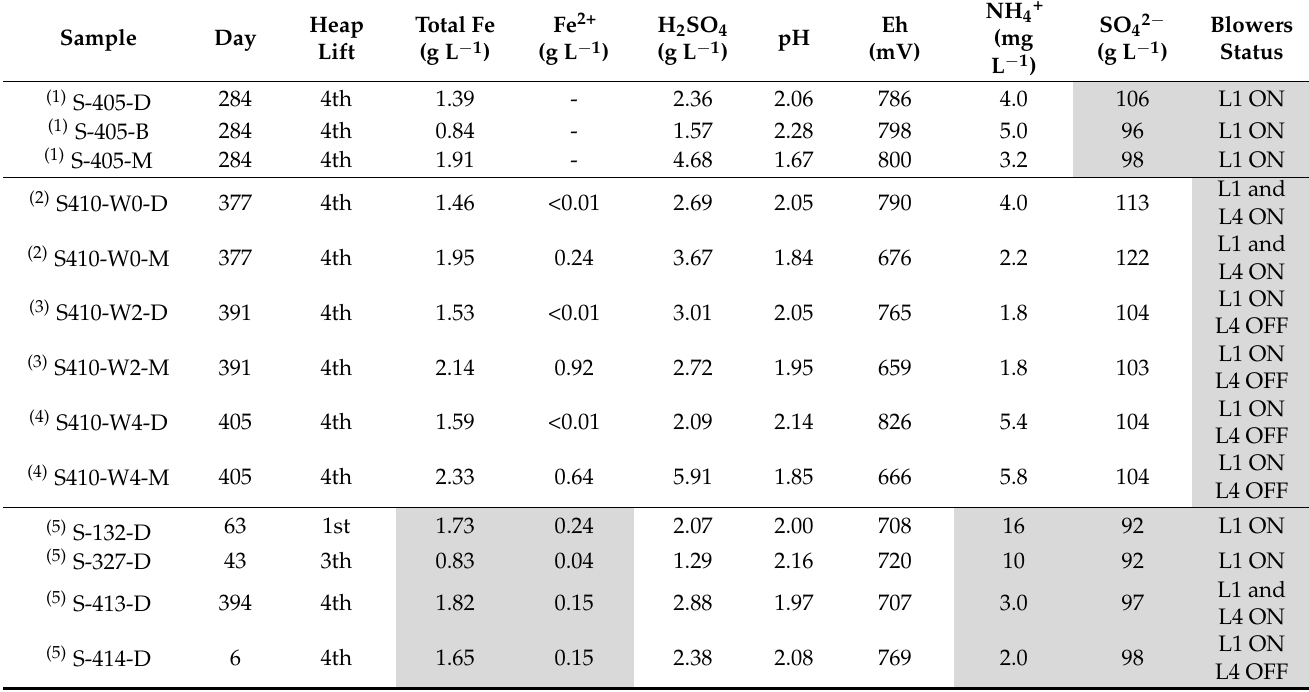
Table 2. Physicochemical characterization of industrial samples from the Minera Escondida Ltd. (MEL) bioleaching heap (strips S-405, S-410, S-132, Scheme 327. S-413, and S-414) sampled at different operation times for gene expression analysis associated with CO 2 availability, osmotic stress, nitrogen availability, and ferrous/sulfur oxidation. Gray areas mark the operational factors and their related metabolisms studied in the respective industrial samples. Industrial strips were sampled on: (1) 24 November 2015; (2) 29 December 2016; (3) 12 January 2017; (4) 26 January 2017; (5) 23 August 2017. The marks W0, W2, and W4 in S-410 correspond to three samplings performed biweekly before (0), after 2 weeks, and after 4 weeks since the blower was turned off. D represents samples collected from the heap base, M represents samples collected at the base of the fourth lift, and B represents a sample collected at the base of the second lift of the heap. L1 and L4 represent blowers present in the heap-base or the fourth lift base, respectively. ON and OFF are blowers turned on and turned off, respectively. Day refers to the strip operation